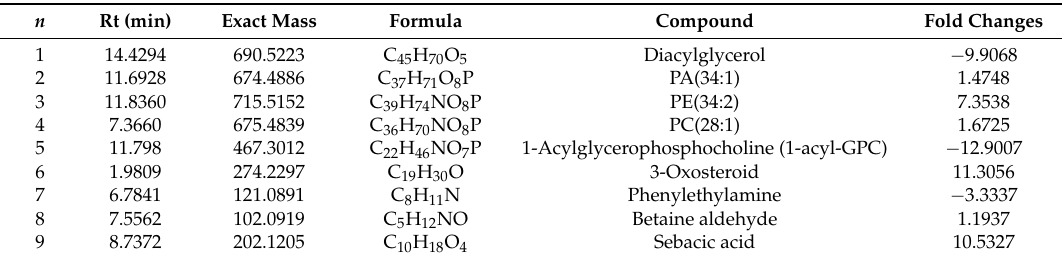
Table 3. Identified differential metabolites in the outcome stage (ILAs) group vs. initial stage (healthy) group.